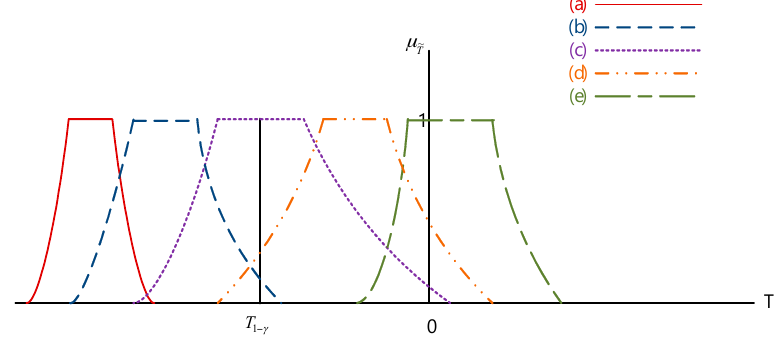
~ for the left-sided test. Figure 4. Five di